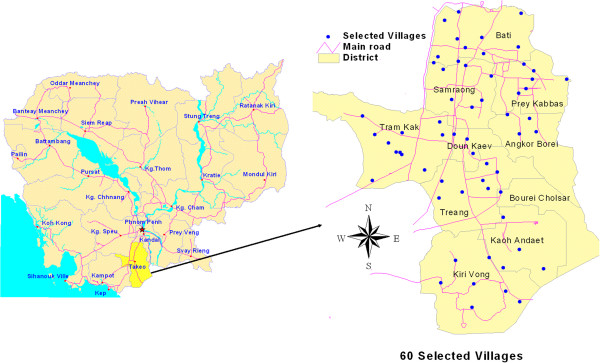
Map of selected villages in Takeo province, Cambodia.